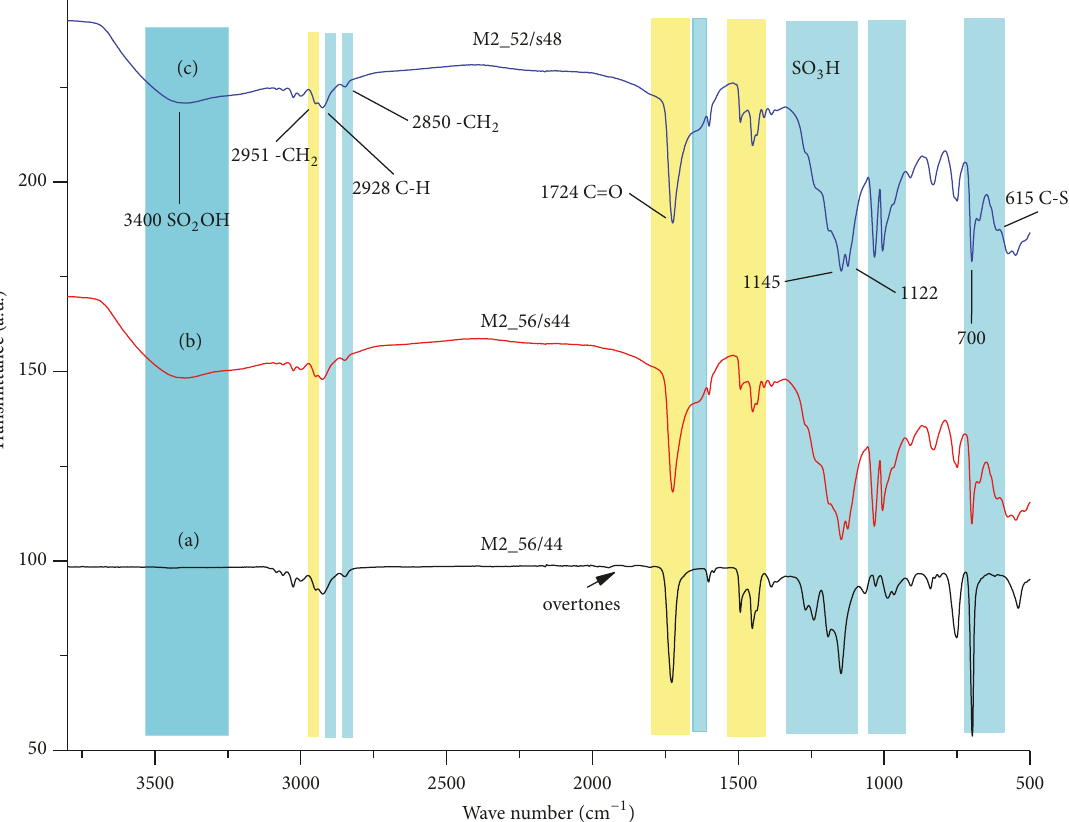
Figure 1: FT-IR spectra of (a) a nonsulfonated PMMA- b -PS (M2 56/44 in Table 1) and of sulfonated BCs (PMMA- b -sPS in Table 2): (b) M2 56/s44 (DS = 87 %) and (c) M2 52/s48 (DS = 90